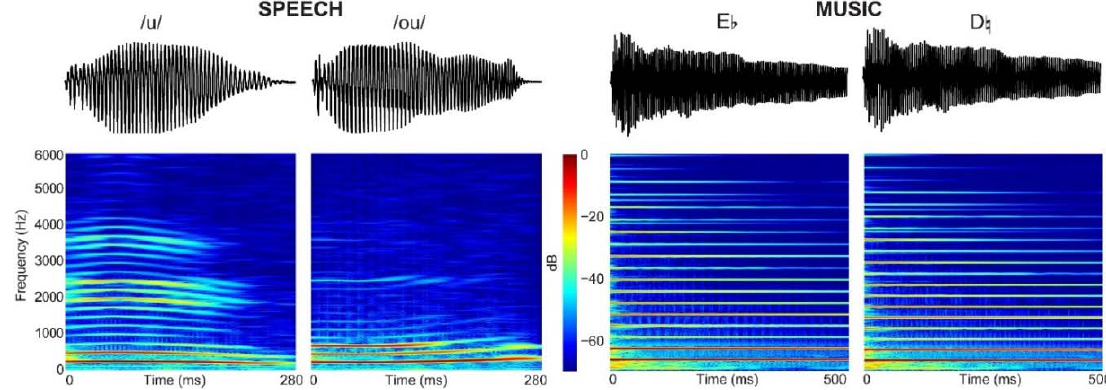
Figure 1. Spectrograms of the auditory stimuli for speech and music oddball paradigms .